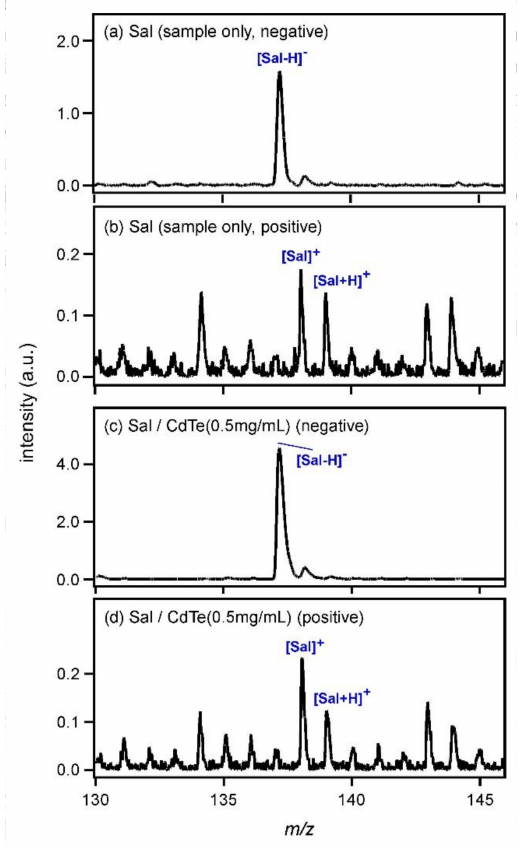
Figure 1. Laser desorption ionization mass spectrum of salicylic acid (Sal) in the ( a ) negative and ( b ) positive ion regions. Matrix-assisted laser desorption ionization mass spectrum of Sal with CdTe nanoparticles as the matrix (0.5 mg/mL) in the ( c ) negative and ( d ) positive ion